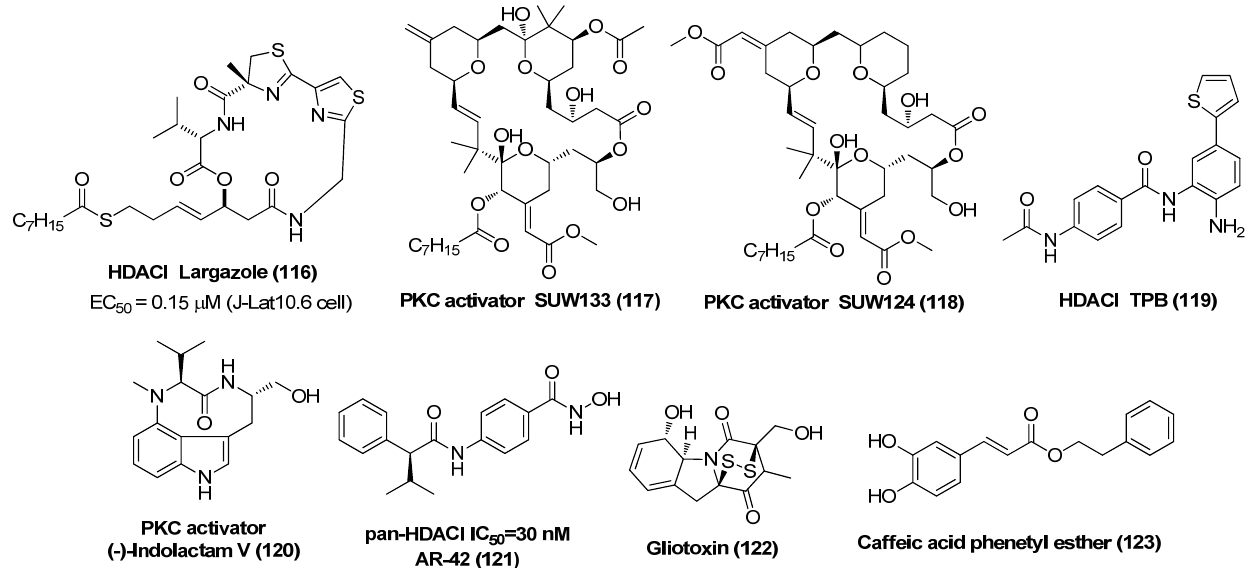
Figure 29. LRAs used as combinational components.